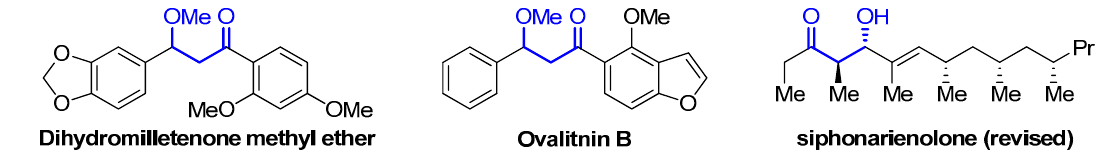
Figure 4. Biologically active β -alkoxy ketones.